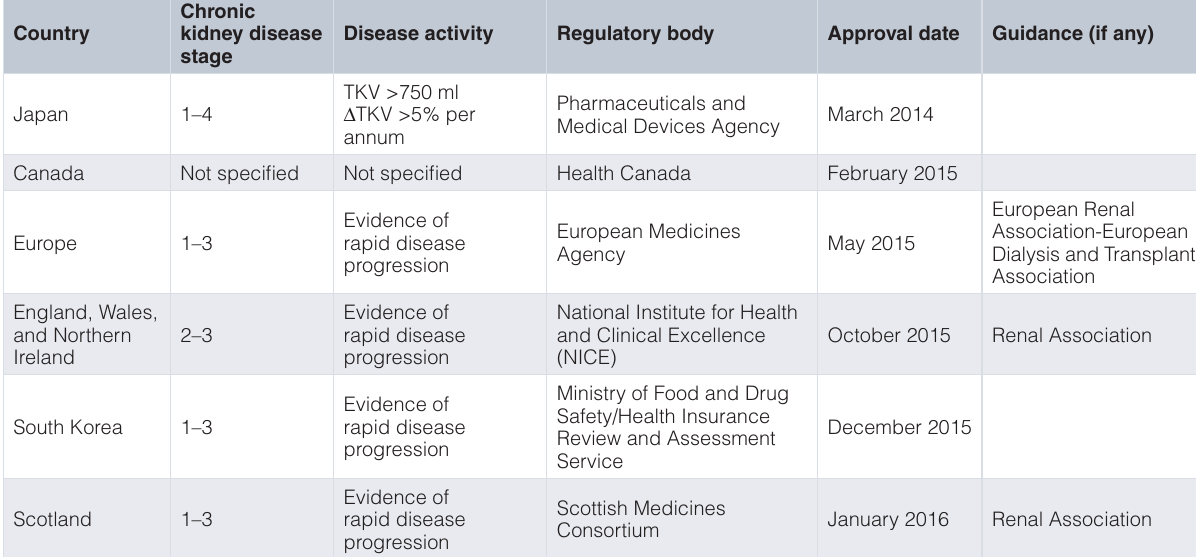
Table 1. Eligibility criteria for the approved use of tolvaptan according to country or region.